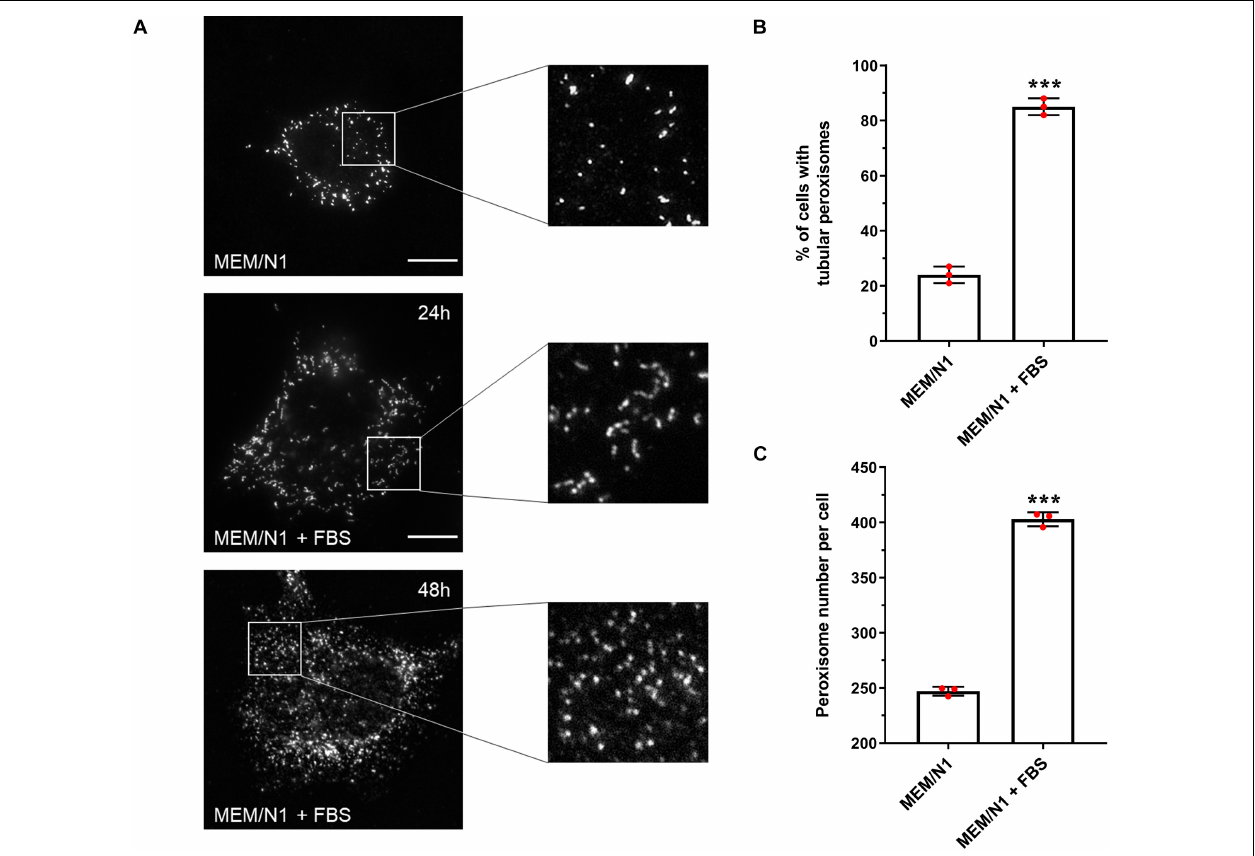
FIGURE 1 | Effect of serum on peroxisome morphology/proliferation in HepG2 cells. (A) Representative images of cells cultured in MEM/N1 and cells stimulated with 10% FBS (MEM/N1 + FBS). Cells were processed for immunofluorescence after 24 or 48 h of stimulation and stained with anti-PEX14 antibodies. Bars, 10 µ m (B) Quantitative analysis of peroxisome elongation after 24 h, expressed as percentage of cells exhibiting tubular peroxisomes. Data from 3 independent experiments ( n = 300 cells in each condition); analyzed by two-tailed unpaired t -test. (C) Quantitative analysis of peroxisome number per cell after 48 h. Data from 3 independent experiments ( n = 10 cells for each condition), analyzed by two-tailed unpaired t -test; *** p <